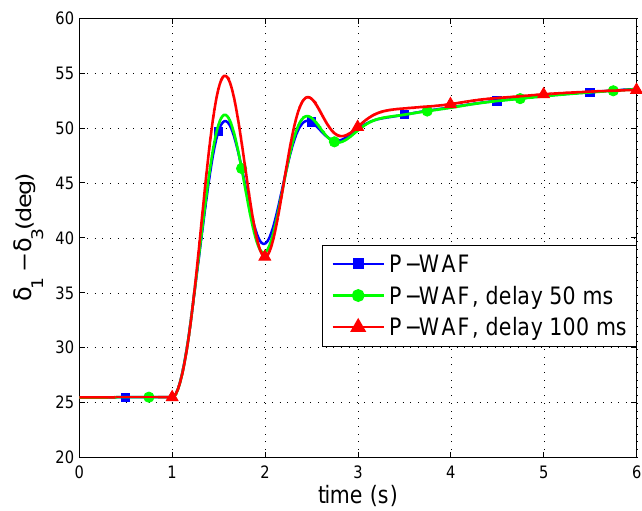
Figure 13. Strategy P-WAF: Impact of communication latency. Generator angle difference.